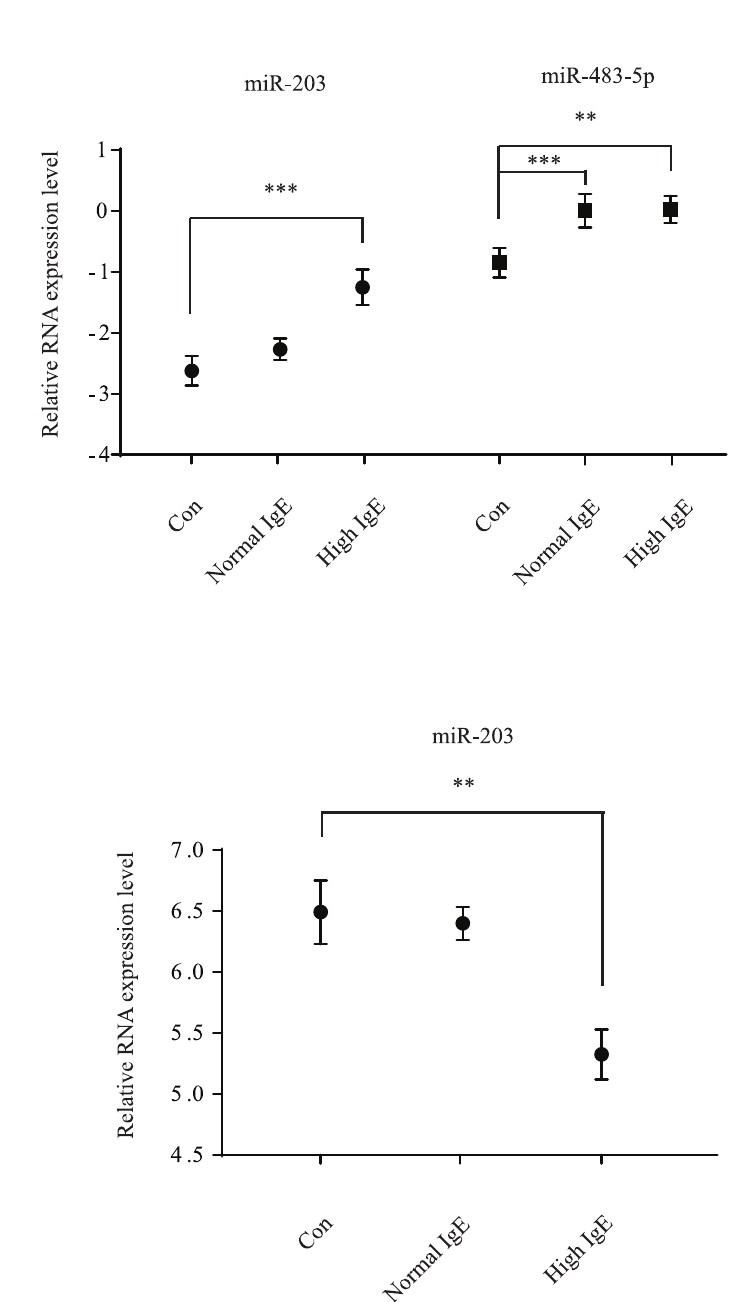
Fig. 4. Groupwise comparison between IgE level and miRNA expression level in children with AD. A . miR-203 and miR-485-5p expression level in serum were measured in patients with higher IgE level and normal IgE level by quantitative real-time PCR. Data are presented as mean values ( ¡ SD). **P , 0.01, ***P , 0.001. B . miR-203 expression level in urine was measured in patients with higher IgE level and normal IgE level by quantitative real-time PCR. Data are presented as mean values ( ¡ SD). **P , 0.01.